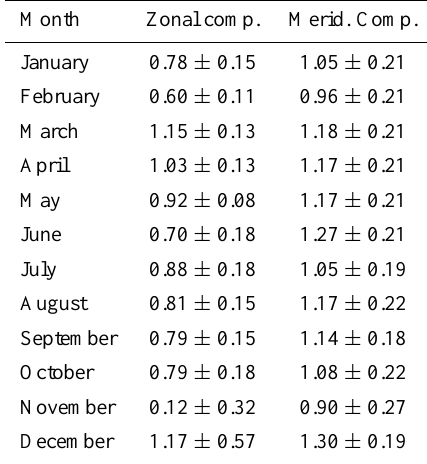
Table 3. Phase of 24-h oscillation (LT). Month Zonal comp. Merid.